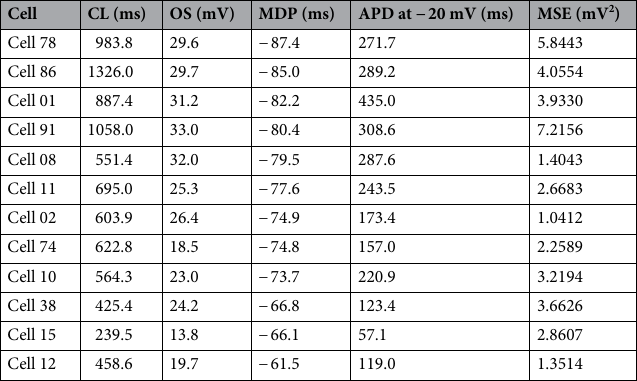
Table 1. AP metrics and MSE calculated after manual fitting of the various AP configurations in 12 different hiPSC-CMs shown in Fig. 2.